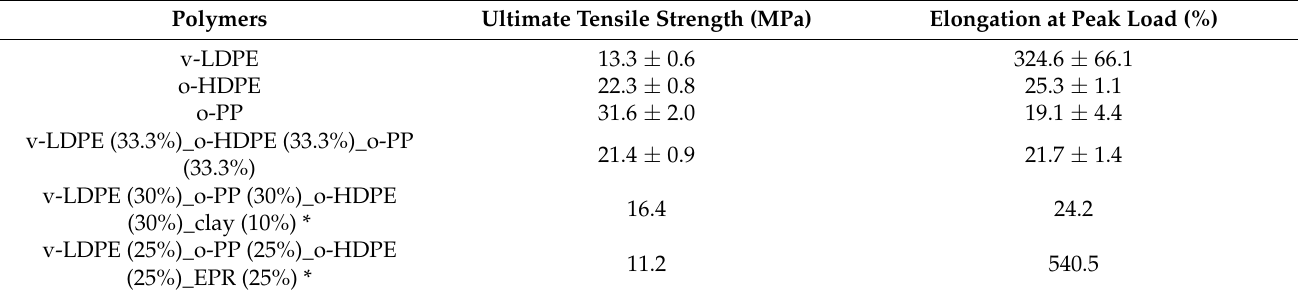
Table 3. Mechanical properties (including ultimate tensile strength and elongation at peak load) of polymer blends composed of o-HDPE, v-LDPE, and o-PP (from the printing tensile bars, n = 3).